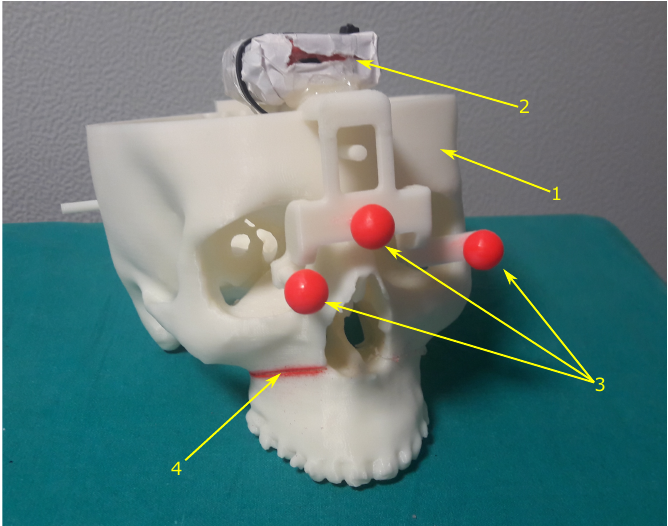
Figure 2. The 3D printed replica of the human skull used in the experimental session as target scene to validate the heterogeneous tracking performance. 1 → The 3D printed replica of the human skull. 2 → The inertial measurement unit (IMU) anchored to the skull replica 3 → The spherical markers of the optical frame. 4 → The red-dyed fracture (a Le Fort 1 osteotomy) considered as reference feature for the assessment of the virtual-to-real overlay